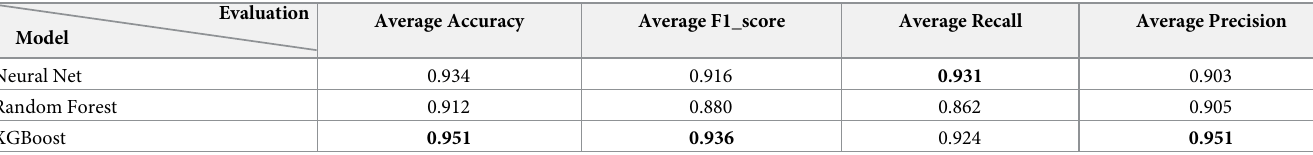
Table 2. Binary classification model evaluations.